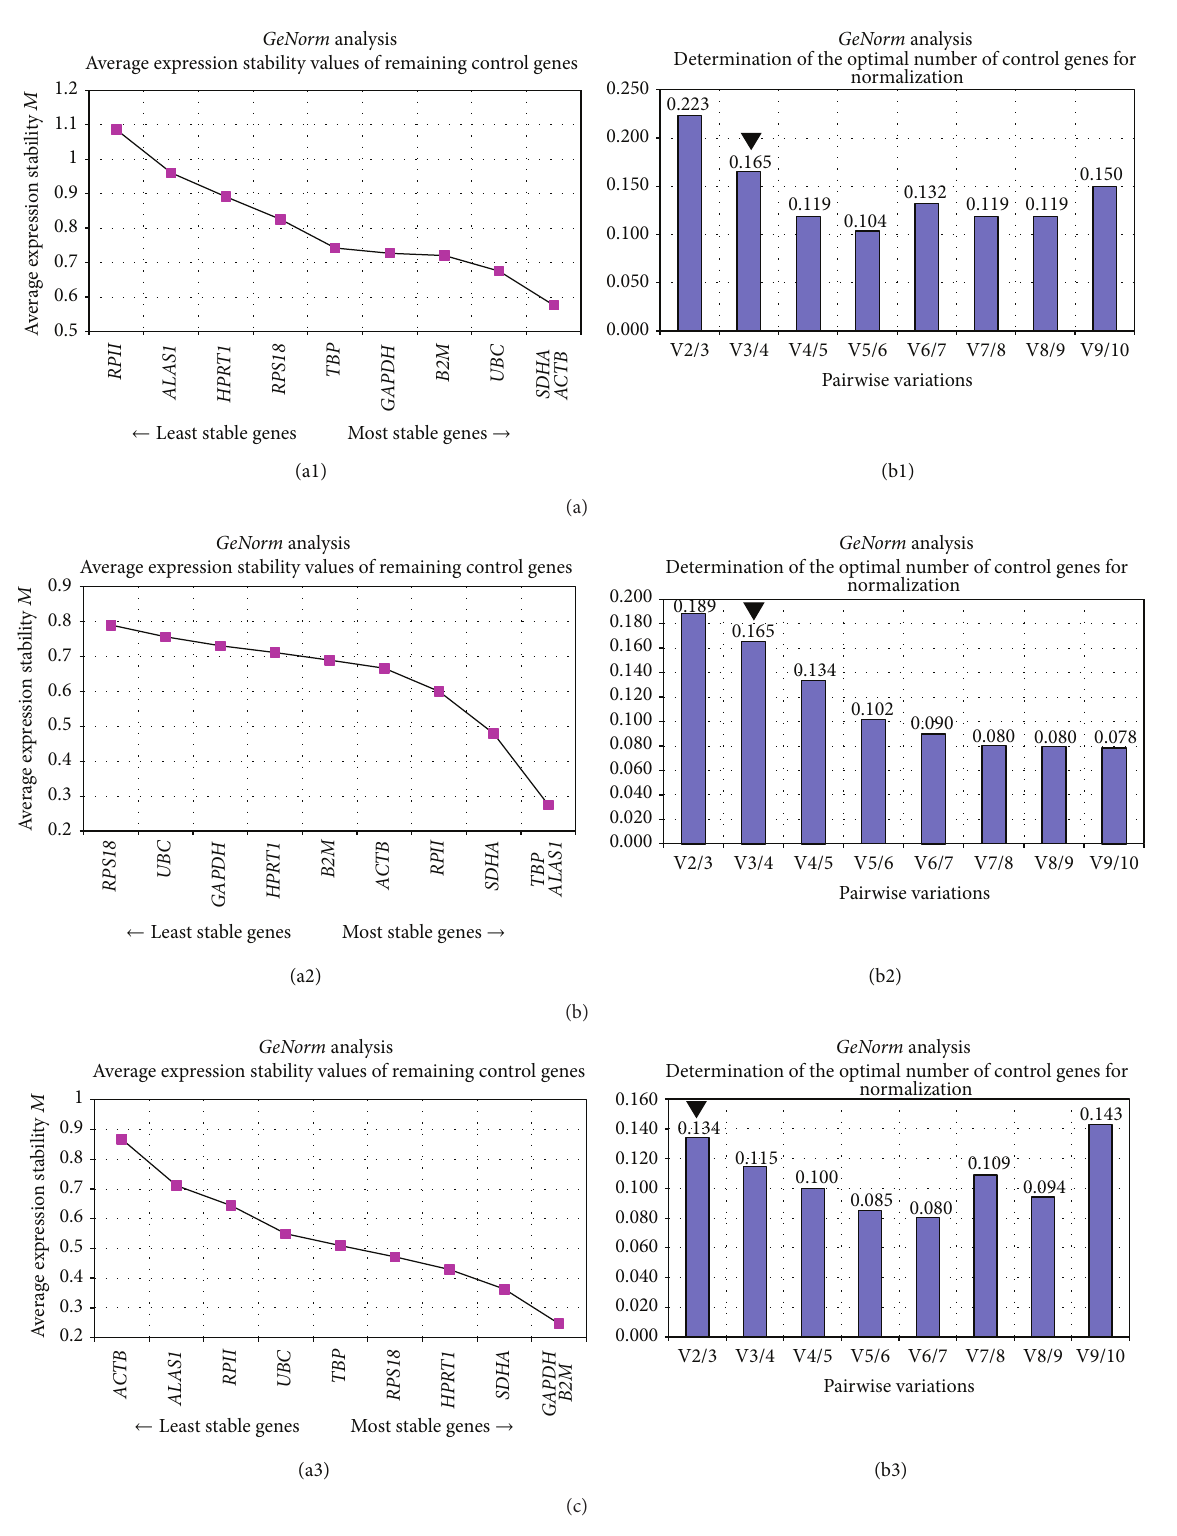
Figure 4: Gene expression stability and minimal number of genes needed in (a) GSC ( 𝑛 = 8 ), (b) dGSC ( 𝑛 = 8 ), and (c) ASC ( 𝑛 = 6 ), by GeNorm. ((a1), (a2), and (a3)) Average expression stability values ( 𝑀 ) for GSC, dGSC, and ASC. A lower 𝑀 value indicated a more stable expression. ((b1), (b2), and (b3)) Pairwise variation value below 0.16 with the least number of reference candidates used is considered optimal for GSC, dGSC, and